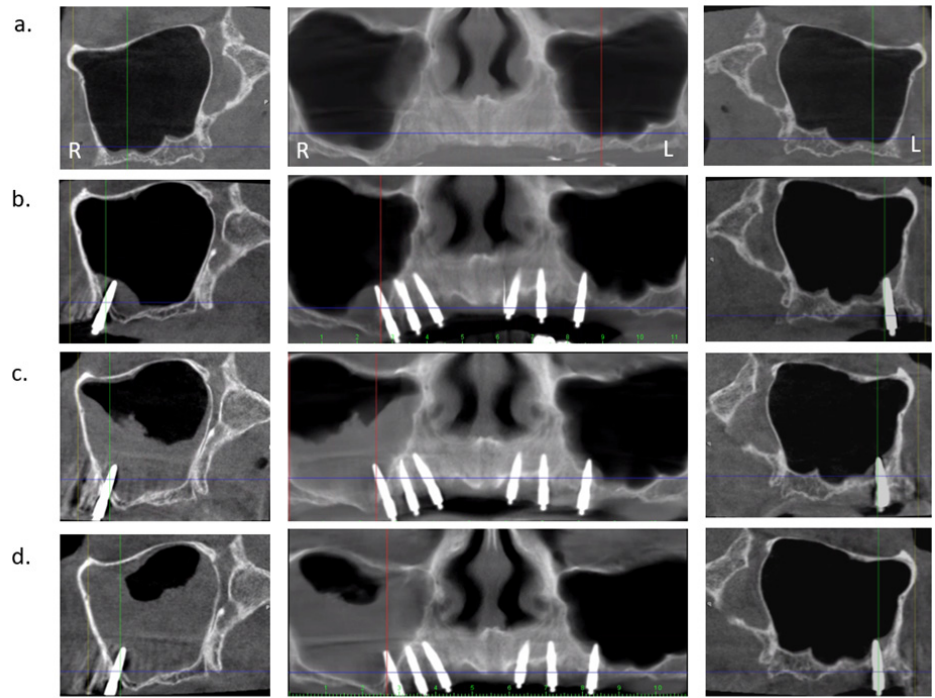
Figure 2. Chronological CBCT assessment of patient in Figure 1: MDI sinusal perforation on both sides with progressive thickening of the Schneiderian membrane at the right side (R) and absence of swelling at the left side (L); ( a ) before surgery (baseline), ( b ) 2 years after surgery, ( c ) 3 years after surgery, and ( d ) 5 years after surgery.